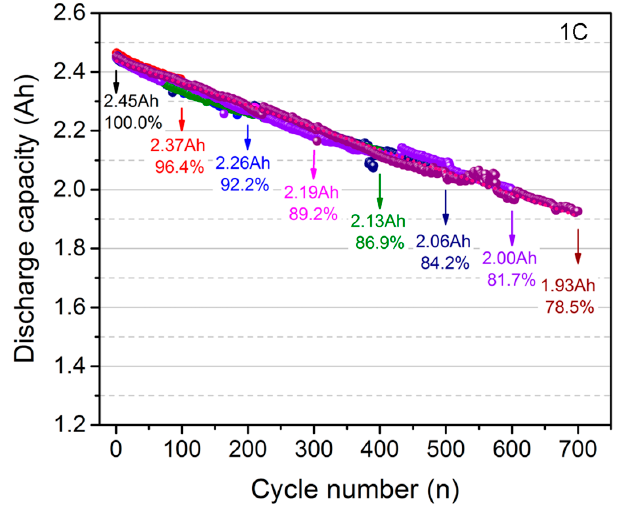
Figure 1. Long-term cycling performance: discharge capacities and capacity retentions of the lithium cobalt oxide (LCO) + NMC532/Gr full cells.